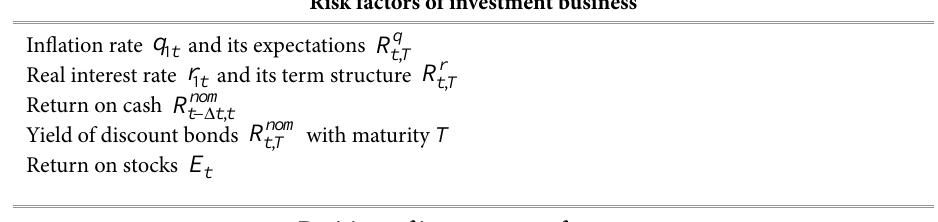
Table 1. Risk factors and decision variables of investment activity Risk factors of investment